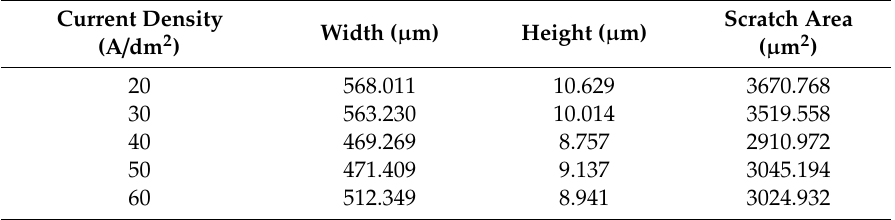
Table 4. Section parameters of wear scars on composite coatings under di ff erent current densities.